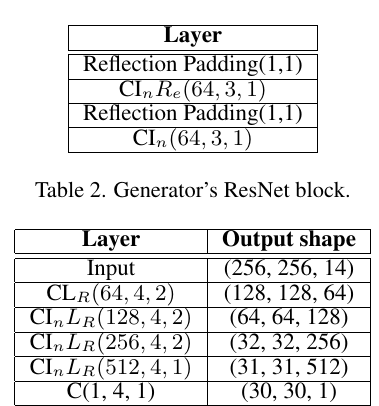
Table 1. CycleGAN’s generator architecture.